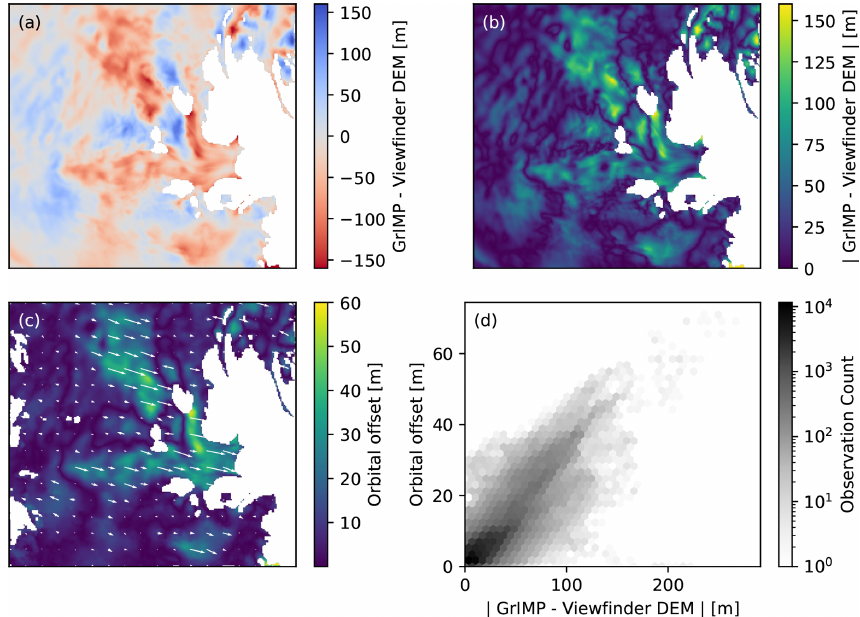
Figure 4. Comparison between DEM vertical differences and velocity offset for Helheim Glacier. (a) DEM difference between the GrIMP DEM and the Viewfinder DEM. (b) Absolute vertical difference between the Viewfinder DEM and GrIMP DEM. (c) Median offset between the measured displacement and expected displacement for velocity fields taken from relative orbits 053 and 139 (identical to Fig. 3c). (d) Hexbin density plot comparing the absolute vertical differences between the Viewfind DEM and GrIMP DEM with the empirically determined orbital